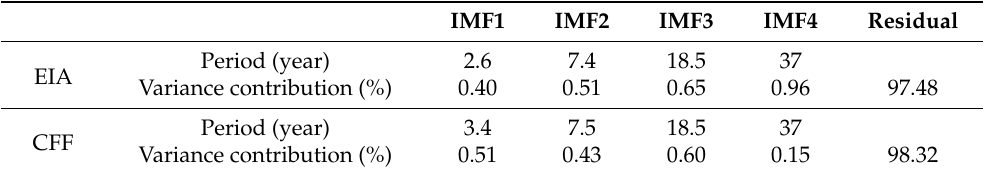
Figure 5. The temporal changes in human activities (EIA ( a ) and CFF ( b )) during 1979 − 2015 at different timescales based on the EEMD method. Table 3. The average periods and their variance contributions of changes in human activities, EIA, and CFF at different timescales in Heilongjiang Province, China during